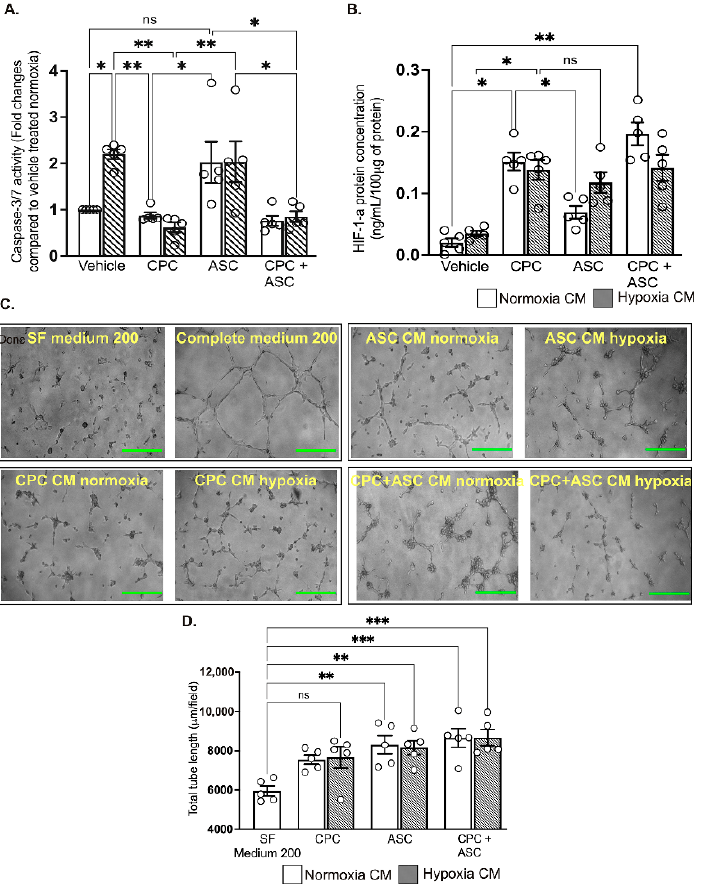
Figure 5. Functional effects of CM on cardiomyocytes and endothelial cells A&B. Quantitative scatter plot column graphs showing caspase-3/7 activity ( A ) and HIF-1 α level; (( B ), measured by ELISA) in AC16 ventricular cardiomyocytes exposed to hypoxia after treatment with either vehicle or CM collected from CPCs and ASCs cultured under normoxia and hypoxia. Caspase-3/7 activity was normalized to the cell number and represented as fold change to vehicle treated group in normoxia (n = 5 patients, quintuplicates). HIF-1 α is expressed as the concentration per 100 ug of protein used for the assay (n = 5 patients, duplicates). Data are mean ± SEM. ( C ) Representative phase contrast images showing tube formation in HUVECs. Scale bars, 500 µm. ( D ) Quantitative scatter plot column graph showing the total tube length (n = 5 patients, triplicates, 2 independent repeats). Data represented as mean (SEM) μ m/field; * p < 0.05, ** p < 0.01 and *** p < 0.001. ns—non significant.